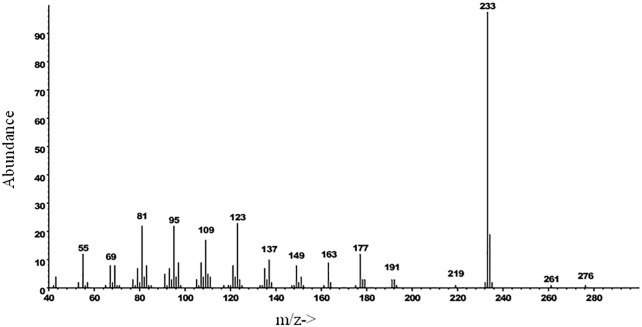
EI mass spectrum of the product from catalytic reduction of the major compound in VOC extracts from B. oleracea var. botrytis.